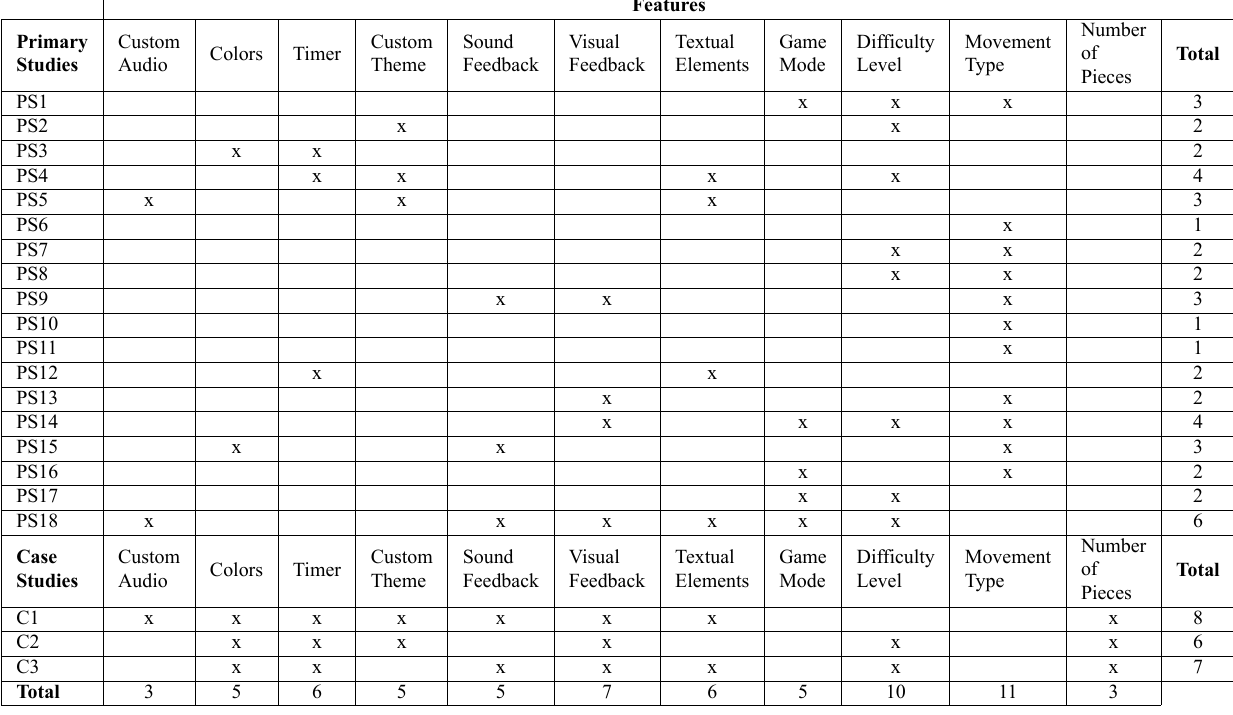
Table 6. Personalization features present in the works of the Literature and in the games developed